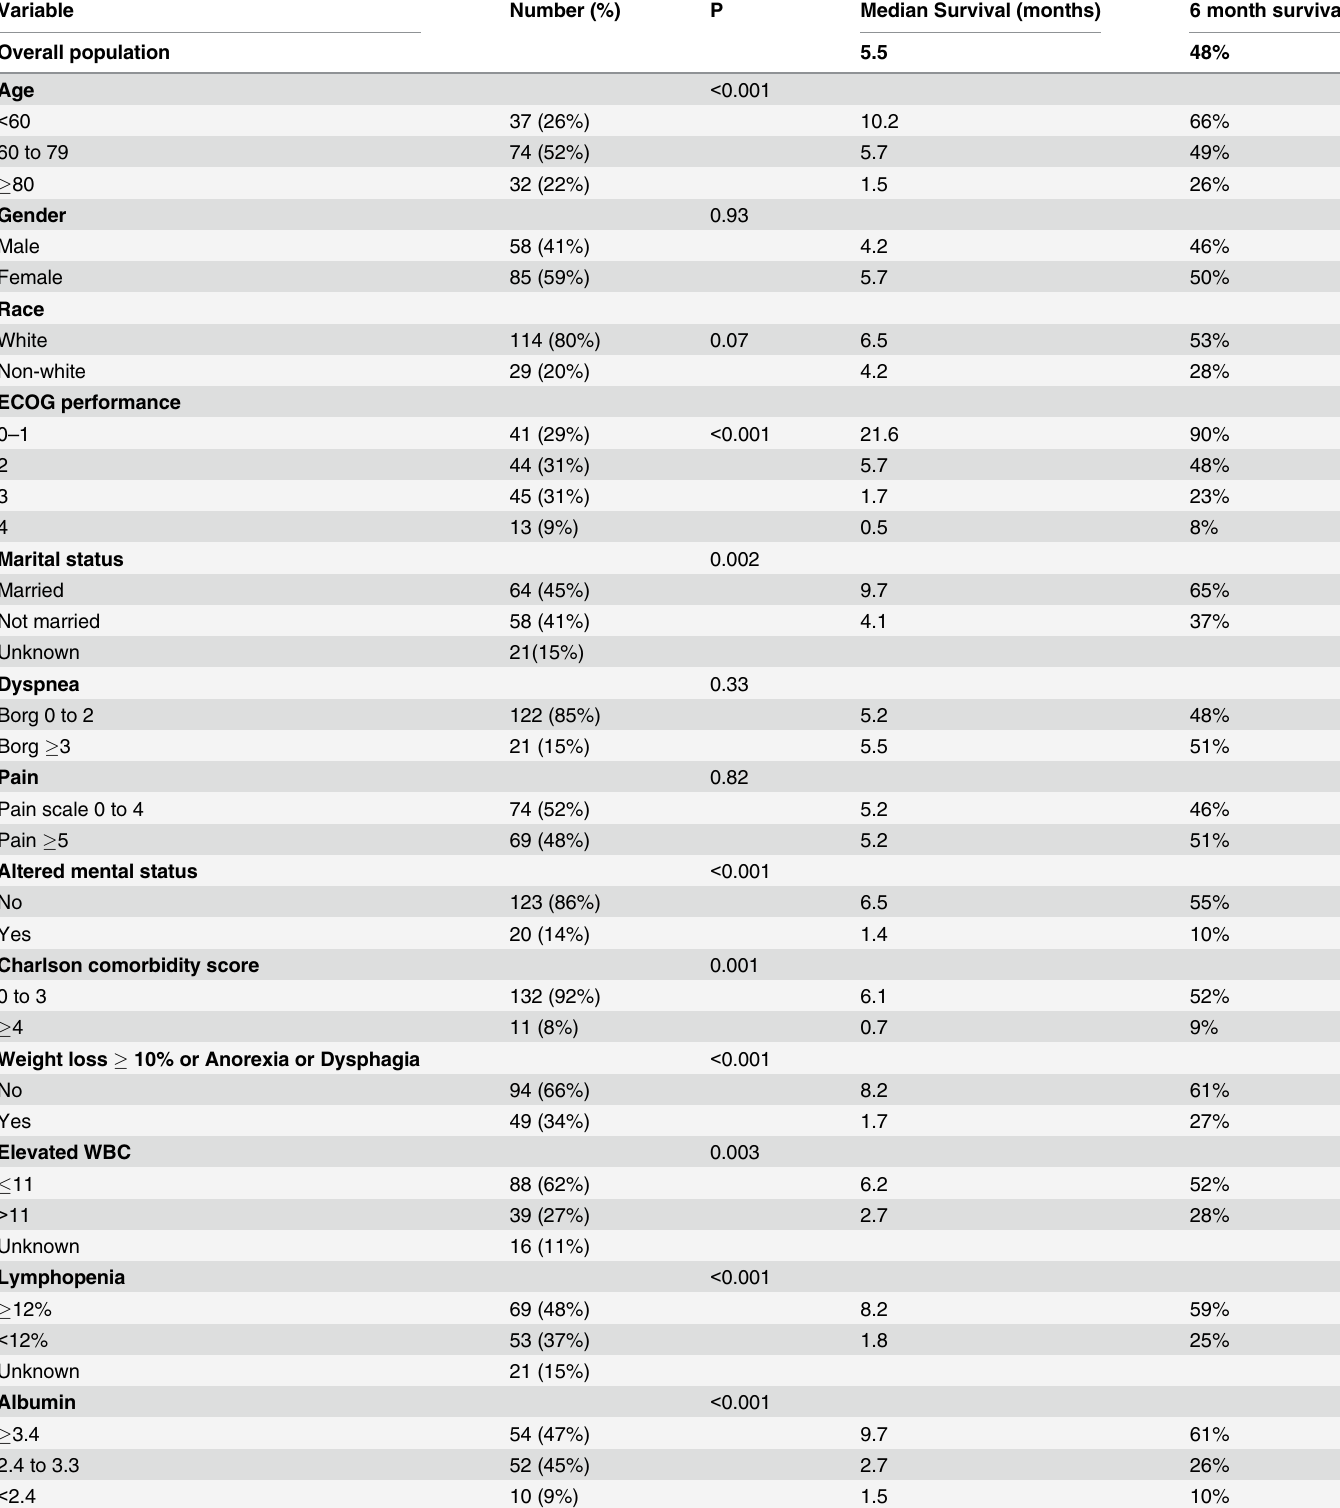
Table 1. Univariate analysis of patient characteristics on survival in patients with advanced